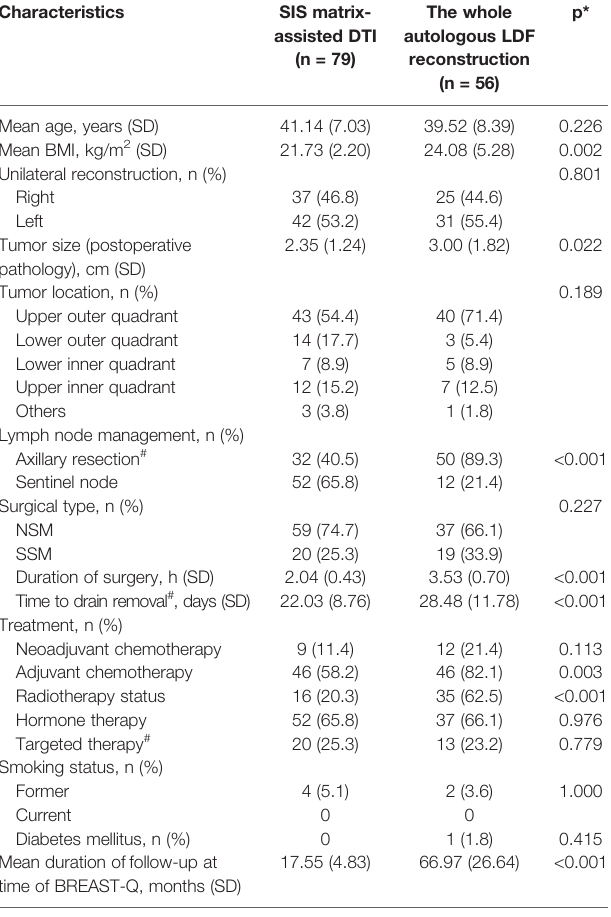
TABLE 4 | Baseline characteristics of the included patients who received DTI or autologous LDF breast reconstruction.